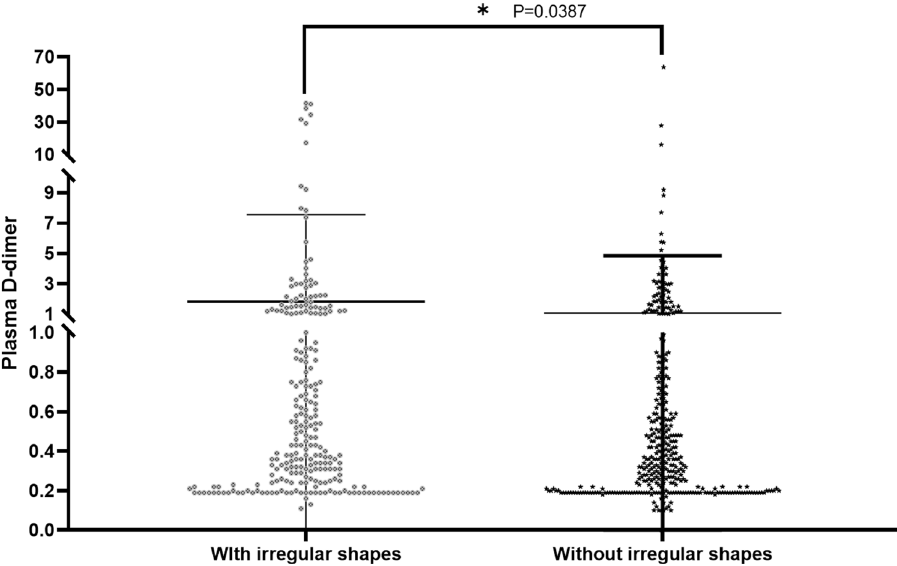
Figure 4. Kaplan–Meier curve analysis showing that the overall survival of patients with spontaneous intracerebral hemorrhage with irregular shapes in intracranial hematoma as worse than that with stable hematoma.